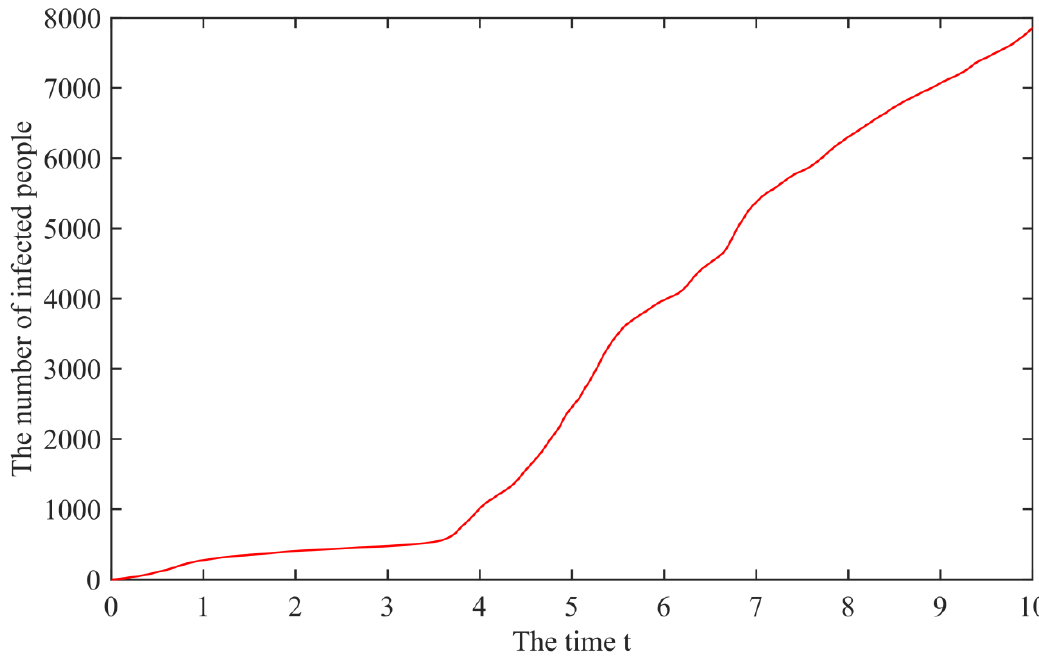
N t as a function of time t for 0.01 β= . Figure 3. The number of infected people ( ) Figure 3. The number of infected people N p ( t ) as a function of time t for β = 0.01. p